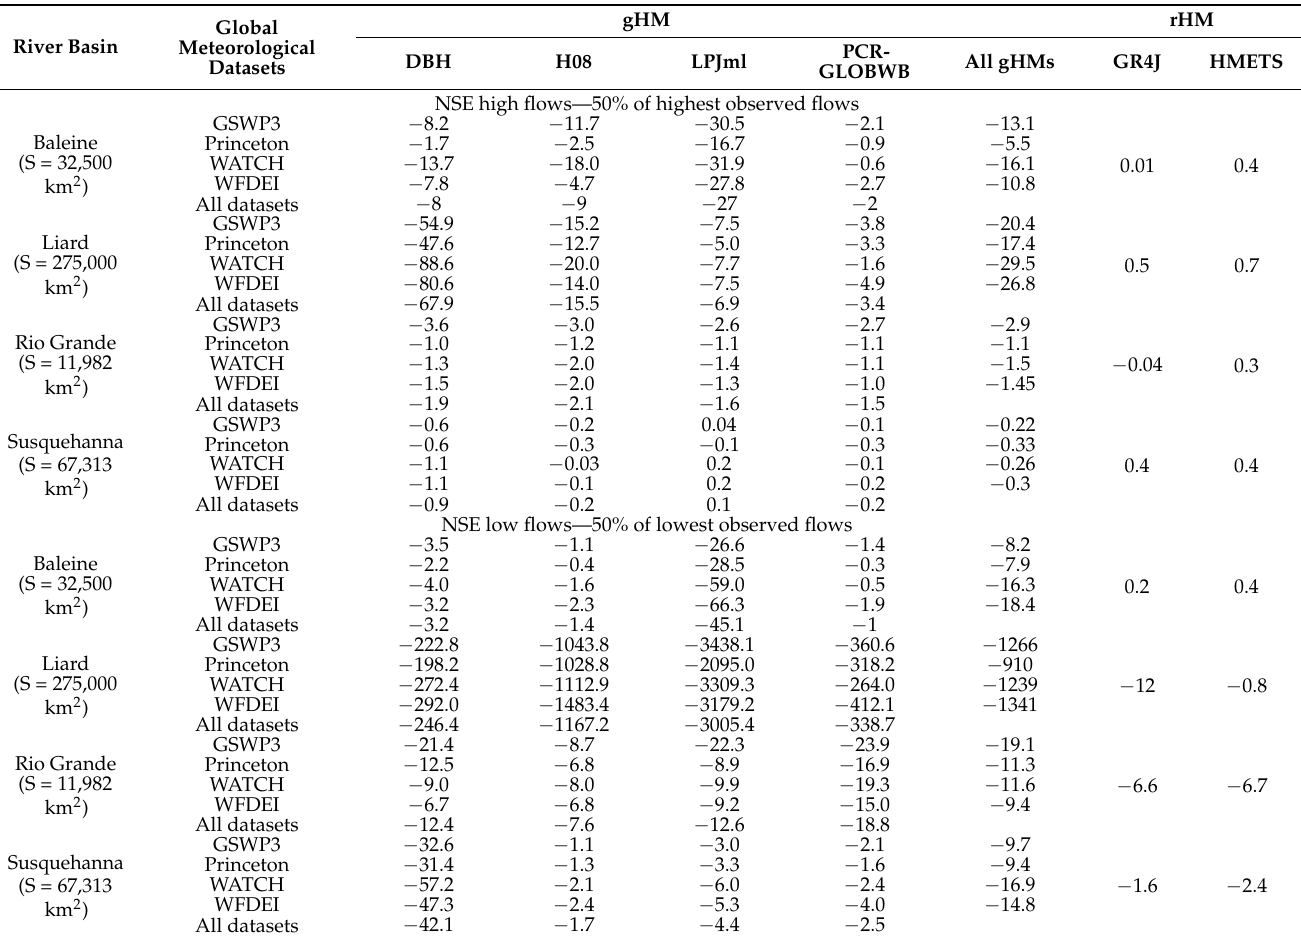
Table 6. NSE values of high and low flows computed for each gHM–climate–dataset combination and the two rHMs for the four catchments over the 1971–2010 period. The satisfactory NSE values are in bold (NSE > 0.5; see Section 2.4). River